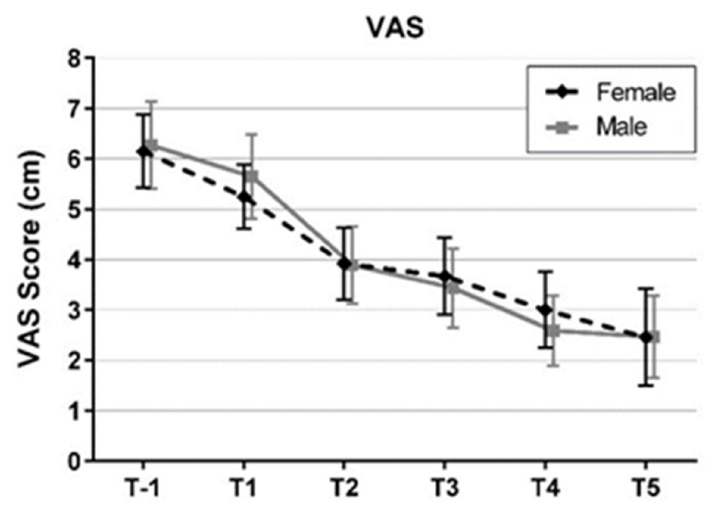
Figure 2. Means and 95% confidence intervals of pain severity from hospital admission (T-1) to day 5 (T5) by gender (VAS: visual analogue scale).